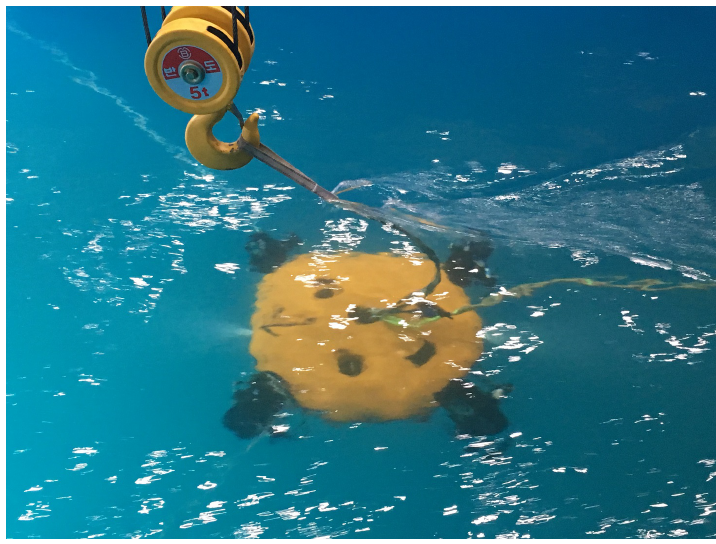
Figure 12. The test in the circulating water channel.